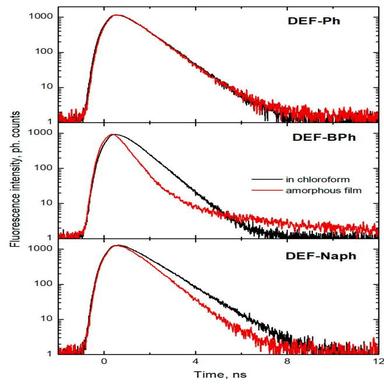
Fluorescence decay kinetics of DEFs: solutions of DEF-Ar in chloroform (black line) and DEF-Ar-amorphous films (red line). λex = 300 nm.